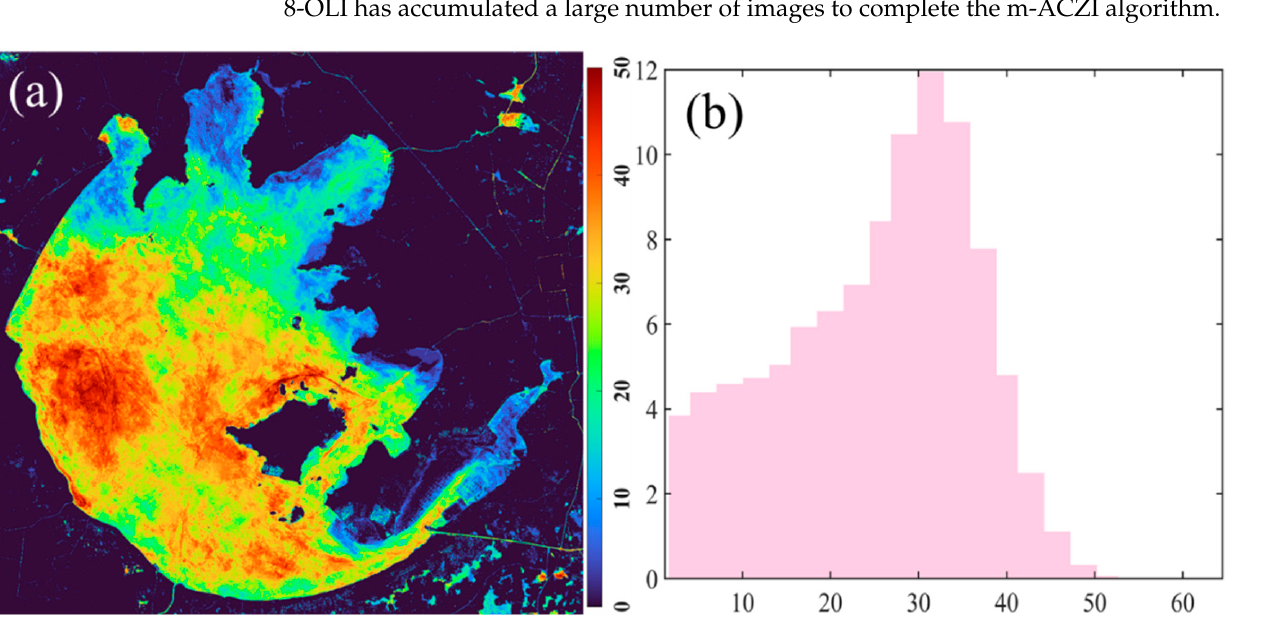
Figure 13. Occurrence probability of BPI pixels ( a ) and its histogram ( b ) in Lake Taihu (2013–2018).